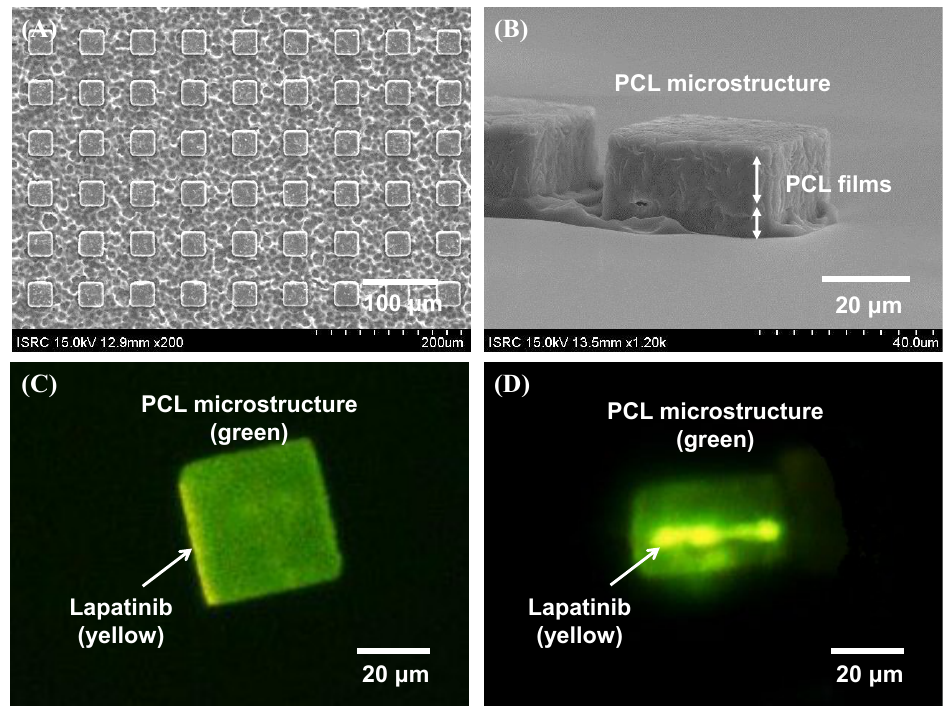
Figure 2. Images of fabricated lapatinib powder-entrapped PCL microstructures. ( A ) Top view of the microstructures by SEM during the development process; ( B ) Side view of the microstructures by SEM after the development process; ( C ) Top view of a microstructure by fluorescent microscope; ( D ) Side view of a microstructure by fluorescent